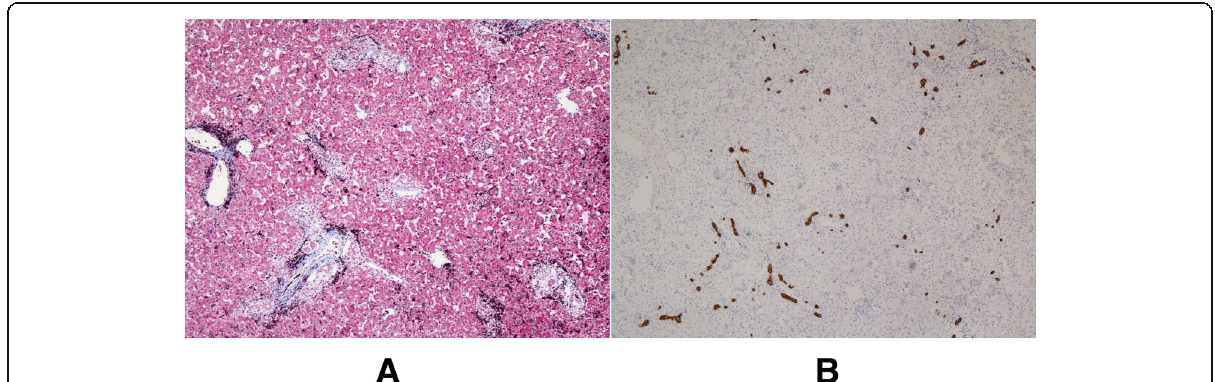
Fig. 4 a Histological findings of the liver biopsy. Liver biopsy stained with Masson ’ s trichrome showed a portal area with mild inflammation and fibrosis. (Masson ’ s trichrome, original magnification × 100). b Immunohistological findings of the liver biopsy. Immunohistological findings of the liver biopsy for cytokeratin 7 showed interlobular bile duct paucity adjacent to the hepatocytes. (cytokeratin 7, original magnification ×